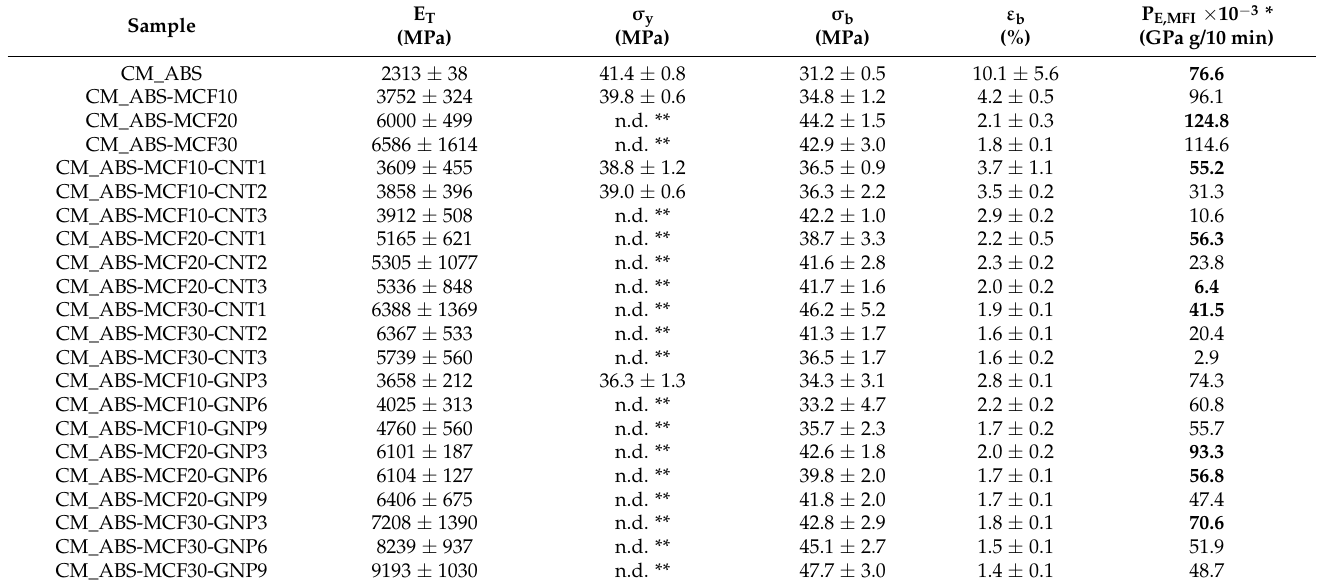
Table 5. Tensile modulus (ET), yield stress ( σ y ), stress at break ( σ b ), and deformation at break ( ε b ) of quasi-static tensile properties of ABS multiscale CM samples. Selection parameters P E,MFI are based on product ET and MFI, according to Equation (8) (the bold values evidence the selected compositions for